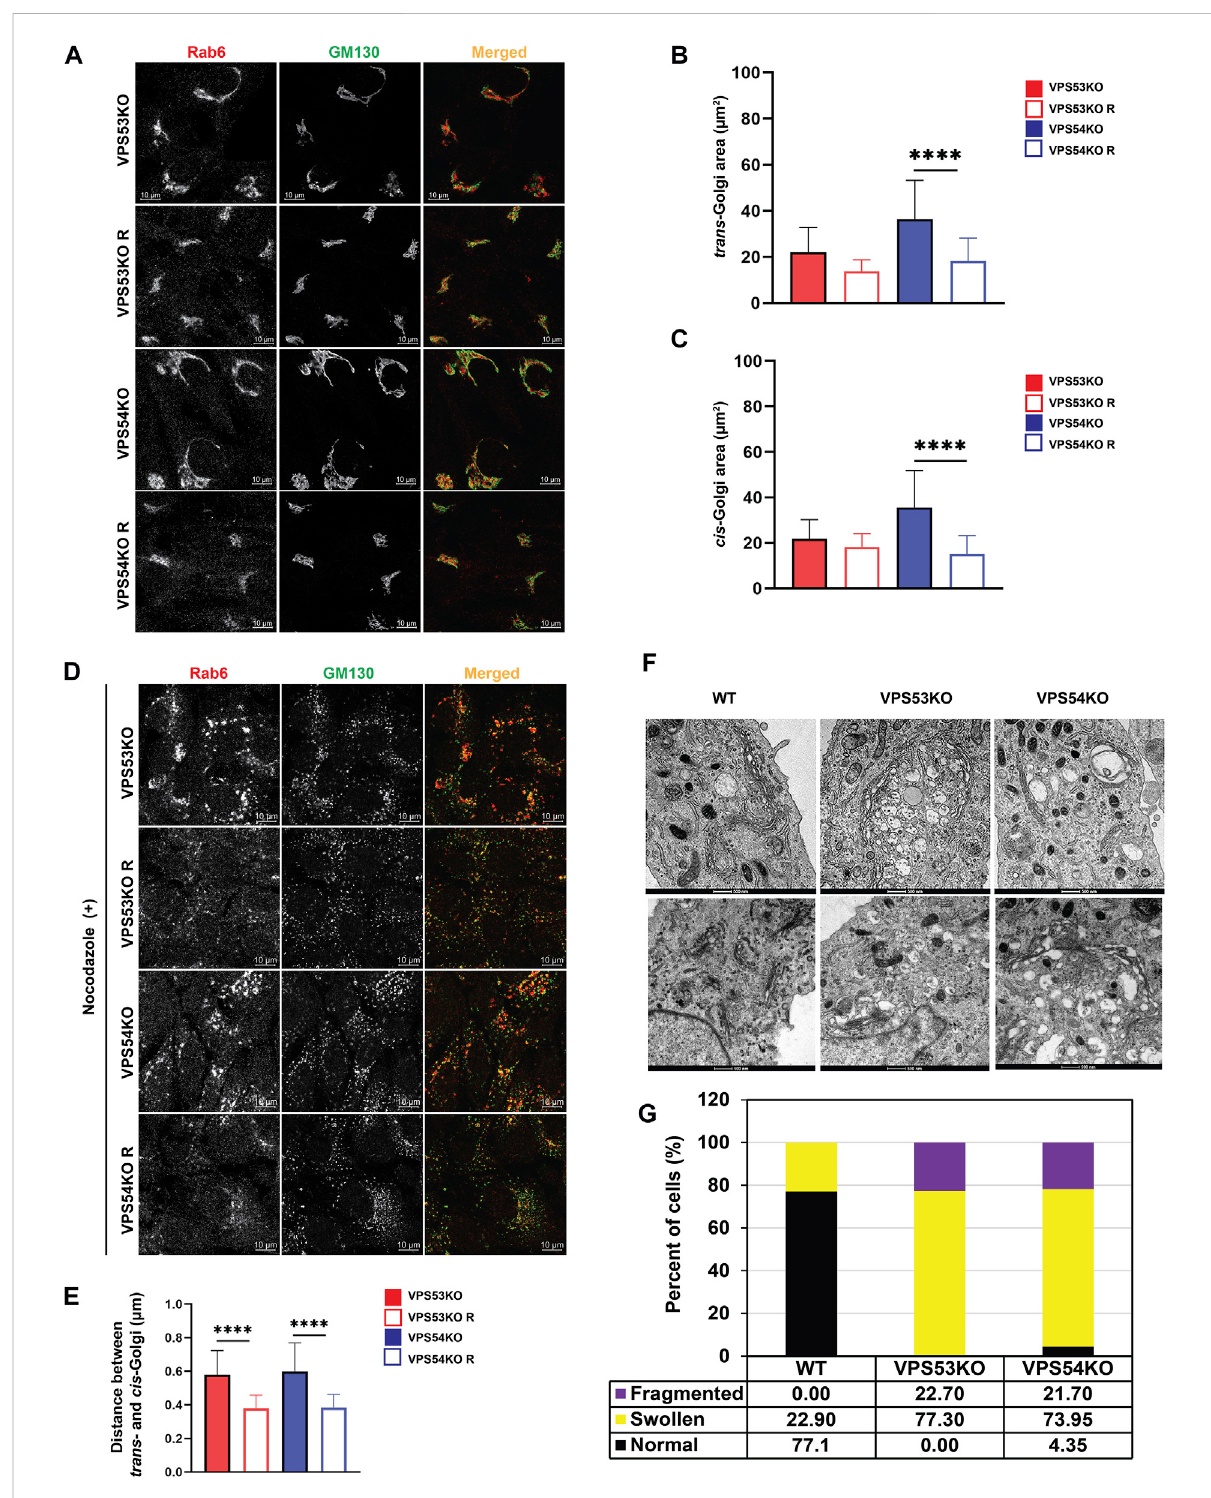
FIGURE 1 GARPde fi ciencyaffectsGolgistructure. (A) AiryscanmicroscopyofVPS53KO,VPS53KOR,VPS54KO,andVPS54KORcellsstainedfor trans -GolgiRab6and cis -GolgiGM130.Individualchannelsarepresentedasblackandwhiteimages,whileoverlaysarepresentedasRGBimages. (B) Quanti fi cationof trans -Golgiarea. (C) Quanti fi cation of cis -Golgi area. n = 30 cells per group. (D) Airyscan microscopy of Nocodazole treated cells, stained for trans -Golgi Rab6 and cis -Golgi GM130. (E) Quanti fi cationofthedistancebetweenthe cis -(GM130)and trans -(Rab6)Golgicompartments. (F) TransmissionelectronmicroscopyofWT, VPS53KO,andVPS54KORPE1cells. (G) Quanti fi cationofnormalandabnormal(swollenorfragmented)GolgiphenotypesinWT,VPS53KO,andVPS54KOcells. n = 30 cells were imaged per group for the quanti fi cation. Statistical signi fi cance was calculated using one-way ANOVA in GraphPad prism. **** p ≤